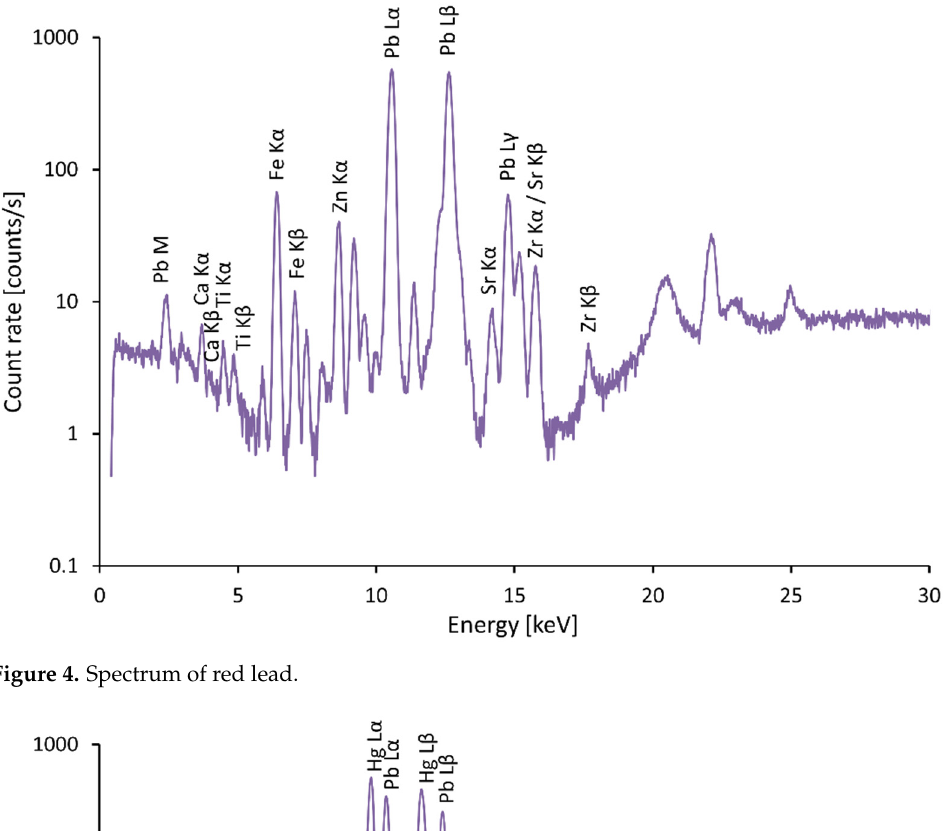
Figure 3. Bust—Anna Palatinate (Anna Pfalz), arrow indicates measured position.